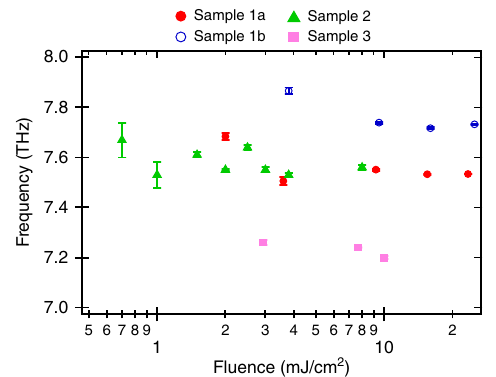
Fig. 2 Fluence dependence of the time-domain frequency for several samples of un-doped V 2 O 3 . All measurements were performed at room temperature. Samples 1a and b where measurements performed at two points on the same sample. A variation of 0.6 THz (~8%) is found over the samples measured. Error bars correspond to the error from the fi t of the Lorentzian obtained from Fourier transforming the time-domain data and are an underestimate. Source data are provided as a Source Data fi